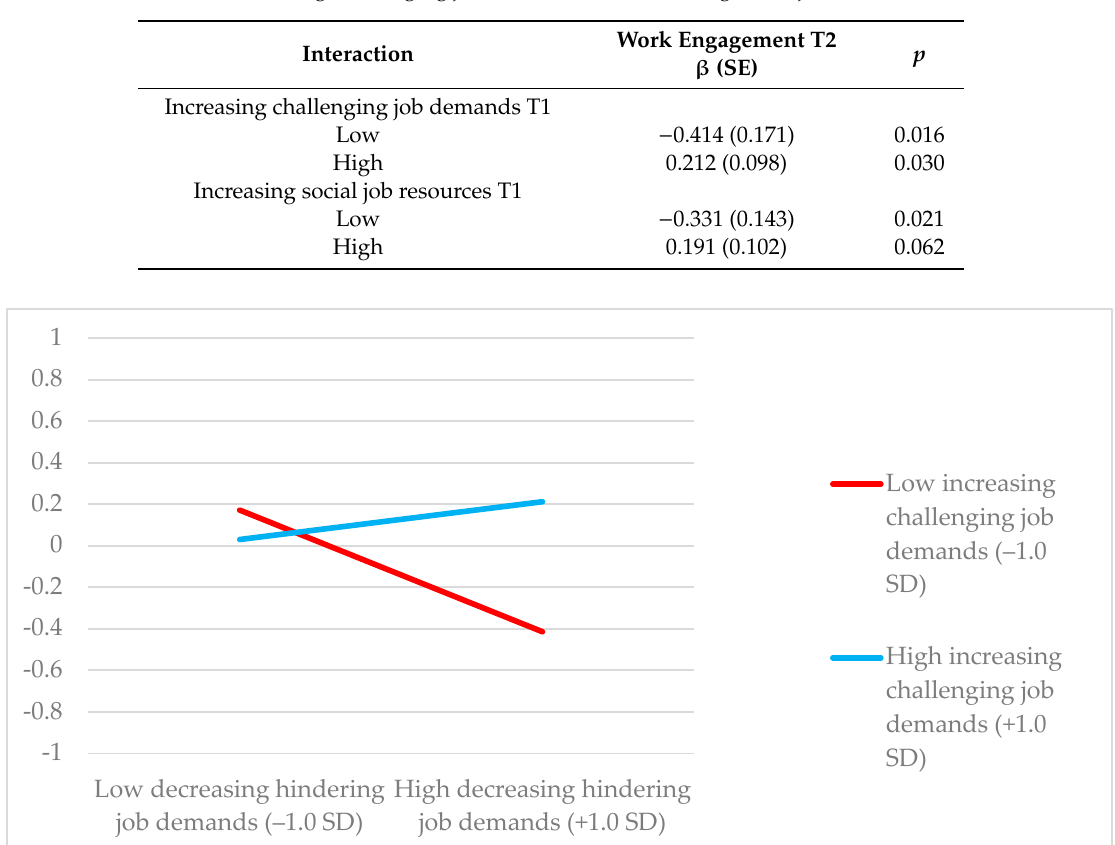
Table 4. Simple slopes between high decreasing hindering job demands and work engagement at high and low levels of increasing challenging job demands and increasing social job resources.